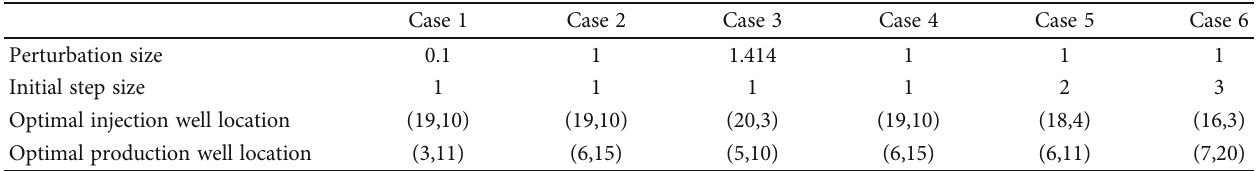
Figure 4: Log-permeability distribution for example 1. Table 1: Result of optimal well locations.